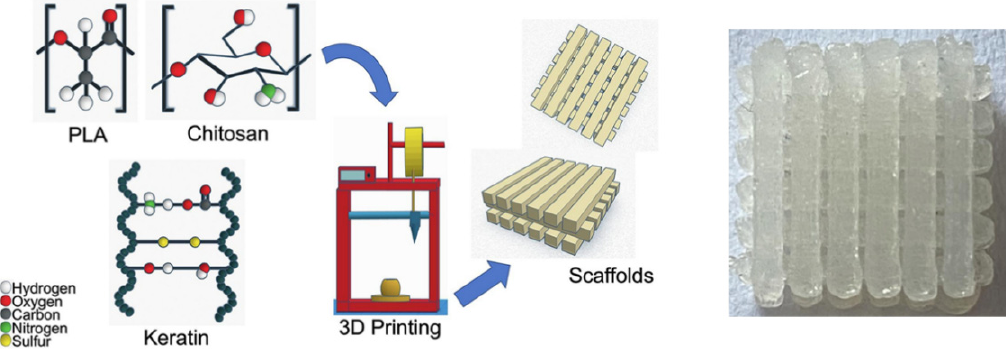
Figure 6. Three-dimensional printing of PLA composite scaffolds reinforced with keratin and chitosan. Reprinted with permission from ref. [108]. Copyright 2020 Elsevier.